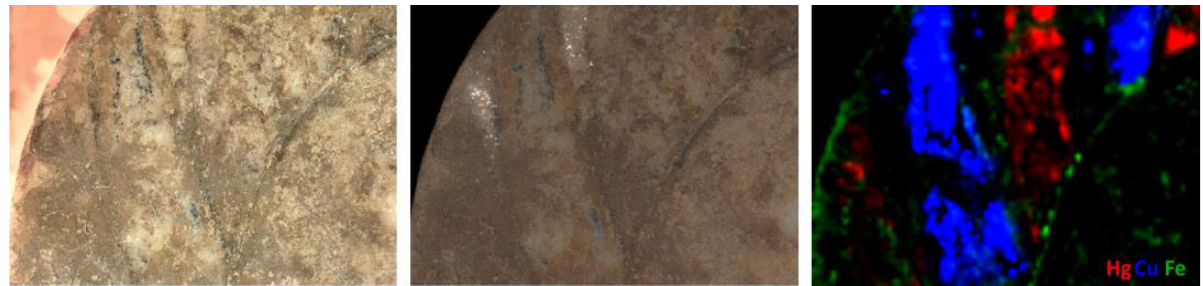
Figure 6. Composite elemental maps of Cu, Fe, and Hg showing the distribution of the corresponding pigments (Cu for azurite and Egyptian blue; Hg for cinnabar) on the wing (area A of Figure 4). Left, VIS image of the scanned area; middle, stacked VIS-VIL image; right, XRF map. The combination of sXRF and VIL revealed the original design of alternating red (Hg, cinnabar) and blue (Cu, azurite, as discussed later) feathers outlined by black lines, against a possibly lighter blue background (Cu, Egyptian blue). The distribution of Egyptian blue and azurite was reconstructed by layering the elemental map of Cu over the VIL image. Although the distribution of Fe appears denser around some of the flight feathers (Figure 6), the original presence and application of Fe-based pigments in the wing remains spec- ulative and deserves further investigation.